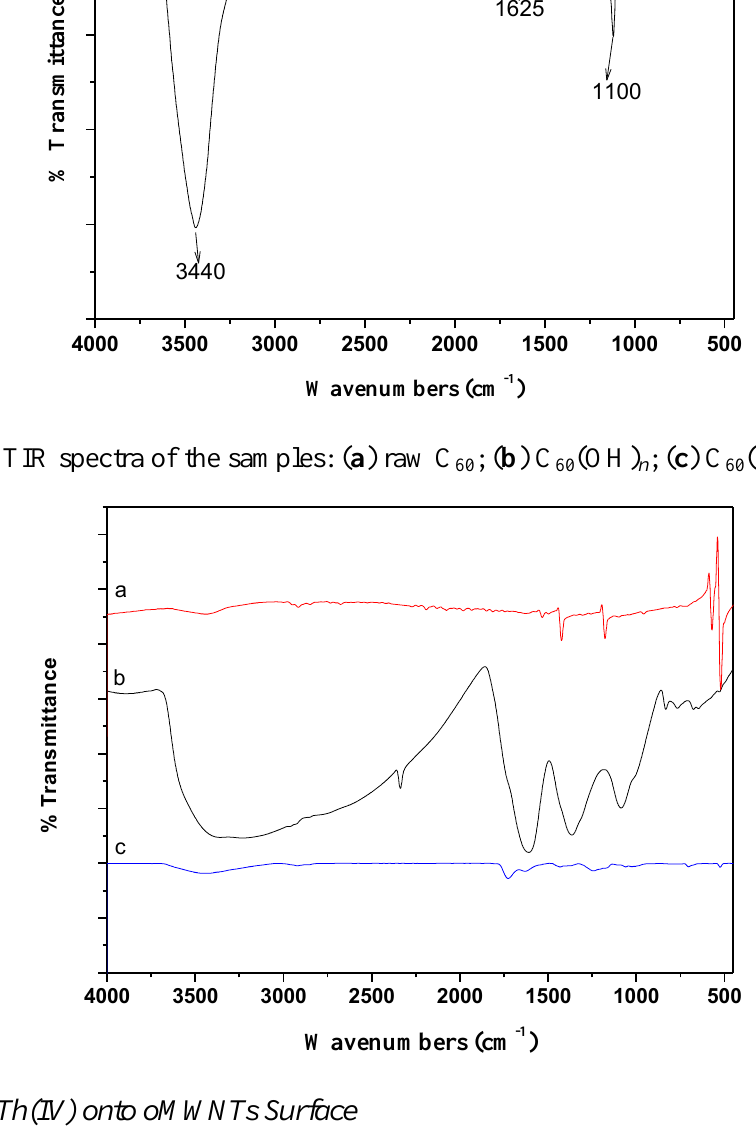
Figure 2. Fourier transform infrared (FTIR) spectra of oMWCNTs.